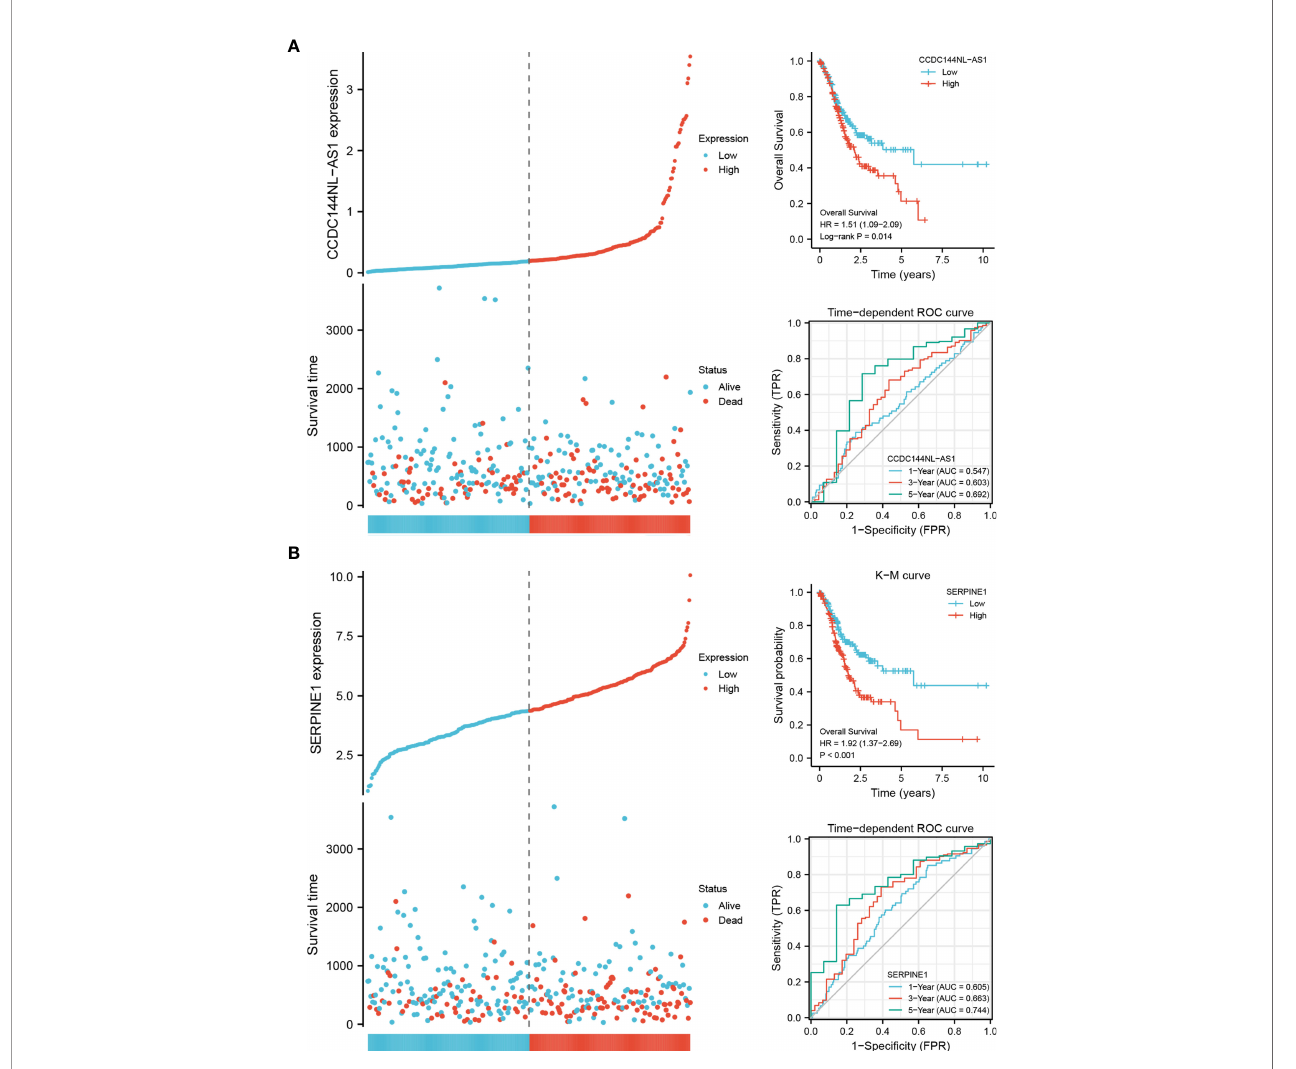
FIGURE 5 | The prognostic biomarkers of CCDC144NL-AS1 and SERPINE1. (A) Expression system, K-M survival analysis and time-dependent ROC curve analysis of CCDC144NL-AS1. (B) Expression system, K-M survival analysis and time-dependent ROC curve analysis of